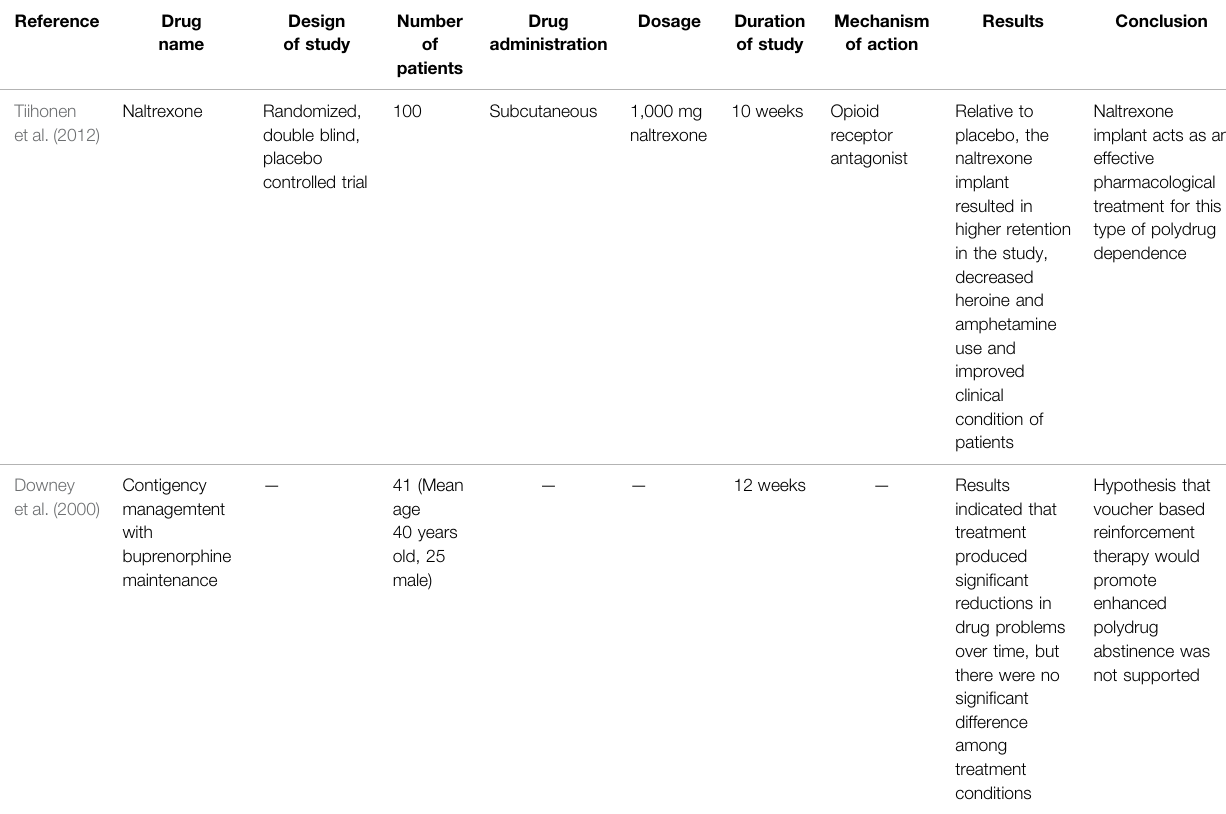
TABLE 3 | Current treatment in polydrug